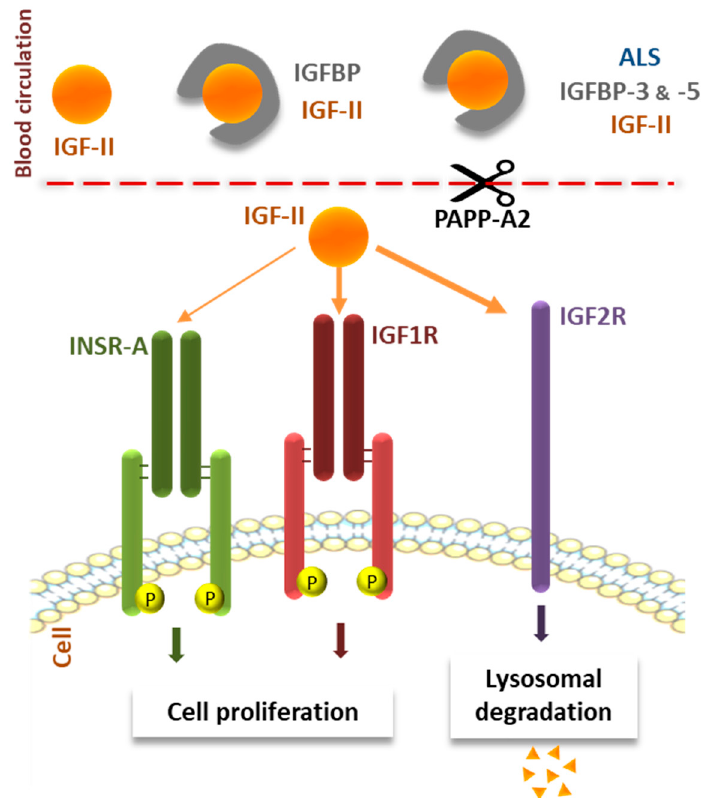
Figure 1. Schematic representation of the modes of action of IGF-II. In the bloodstream, IGF-II is mostly bound in a ternary complex with the acid-labile subunit (ALS) and IGF-binding proteins (IGFBP)-3 and -5. Once released from this complex by PAPP-A2 proteolysis, IGF-II can bind either the type A insulin receptor (INSR-A) or IGF receptor type 1 or 2 (IGF-1R and IGF-2R), inducing cell proliferation or IGF-II clearance.